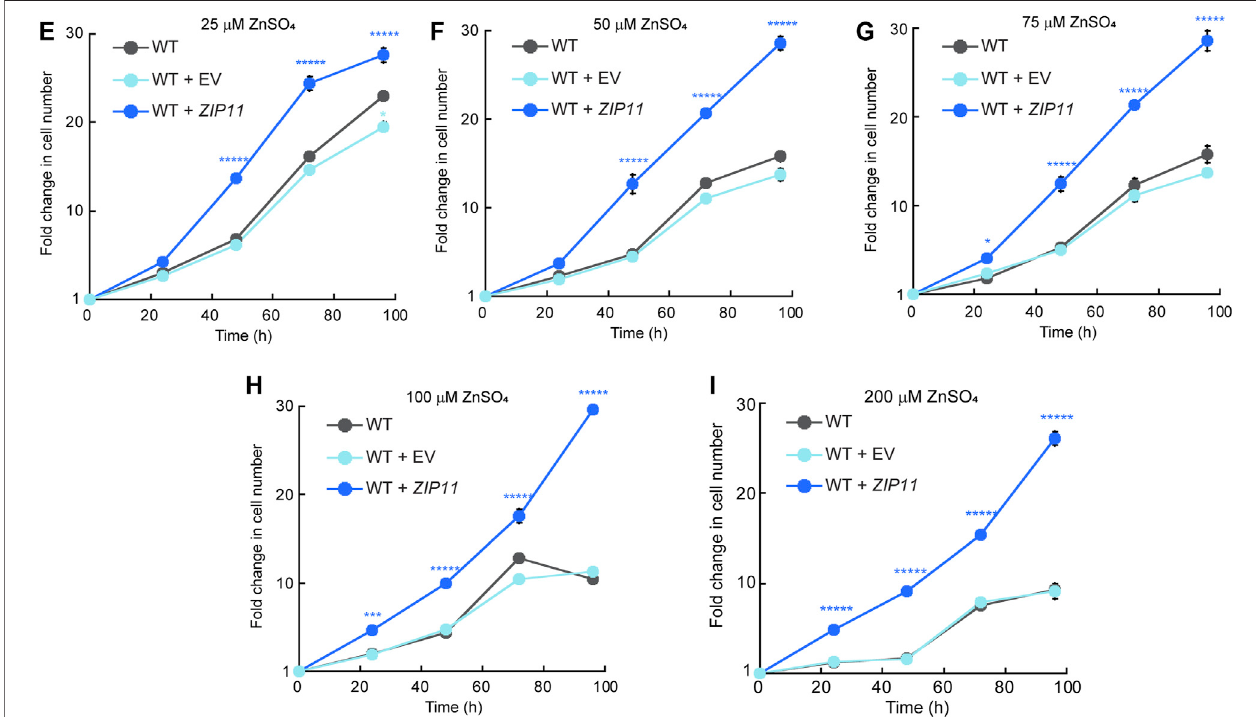
FIGURE 6 | Overexpression of ZIP11 in WT HeLa enhances growth and resistance to elevated levels of Zn. (A) Representative immunoblot (left) and quanti fi cation (right) of ZIP11 levels in HeLa proliferating cells. WT cells were transduced with a plasmid encoding the ZIP11 gene or the empty vector as control. Immunoblots against MTF1showsnochangesintheexpressionofthemetalloprotectivetranscriptionfactorinWTHeLacellsoverexpressingZIP11.ImmunoblotagainstGAPDHwasusedas loading control. (B) Cell counting assay of proliferating cells WT HeLa cells expressing exogenous ZIP11 or empty vectors. (C) Representative confocal micrographies of ZIP11 (red) and Golgin-97 (green) showing the enhanced expression and perinuclear and vesicular distribution of ZIP11 in wild type HeLa cells stably expressing ZIP11 or the empty vector (EV). Nuclei was stained with DAPI. Bar = 10 µm. (D) Wild type cells stably expressing ZIP11 or the empty vector were allowed to grow for 48 h and subcellular fractions were obtained using the REAP protocol. Whole cell (left) cytosolic (middle) and nuclear (right) Zn content determined by AAS (Itzhaketal.,2016;Gordonetal.,2019a;Tavera-Montañezetal.,2019). (E – I) AnalysesofZnresistanceincellsoverexpressionofthe ZIP11 gene.Cellcountingassayof proliferating cells transduced with the ZIP11 gene or an empty vector, cultured for 96 h with increasing concentrations of ZnSO4. (E) 25 µM. (F) 50 µM. (G) 75 µM. (H) 100 µM. (I) 200 µM. The data represents the mean ± SE for three independent experiments. For all samples, data are the mean ± SE of three independent biological replicates. * p < 0.05; ***** p <